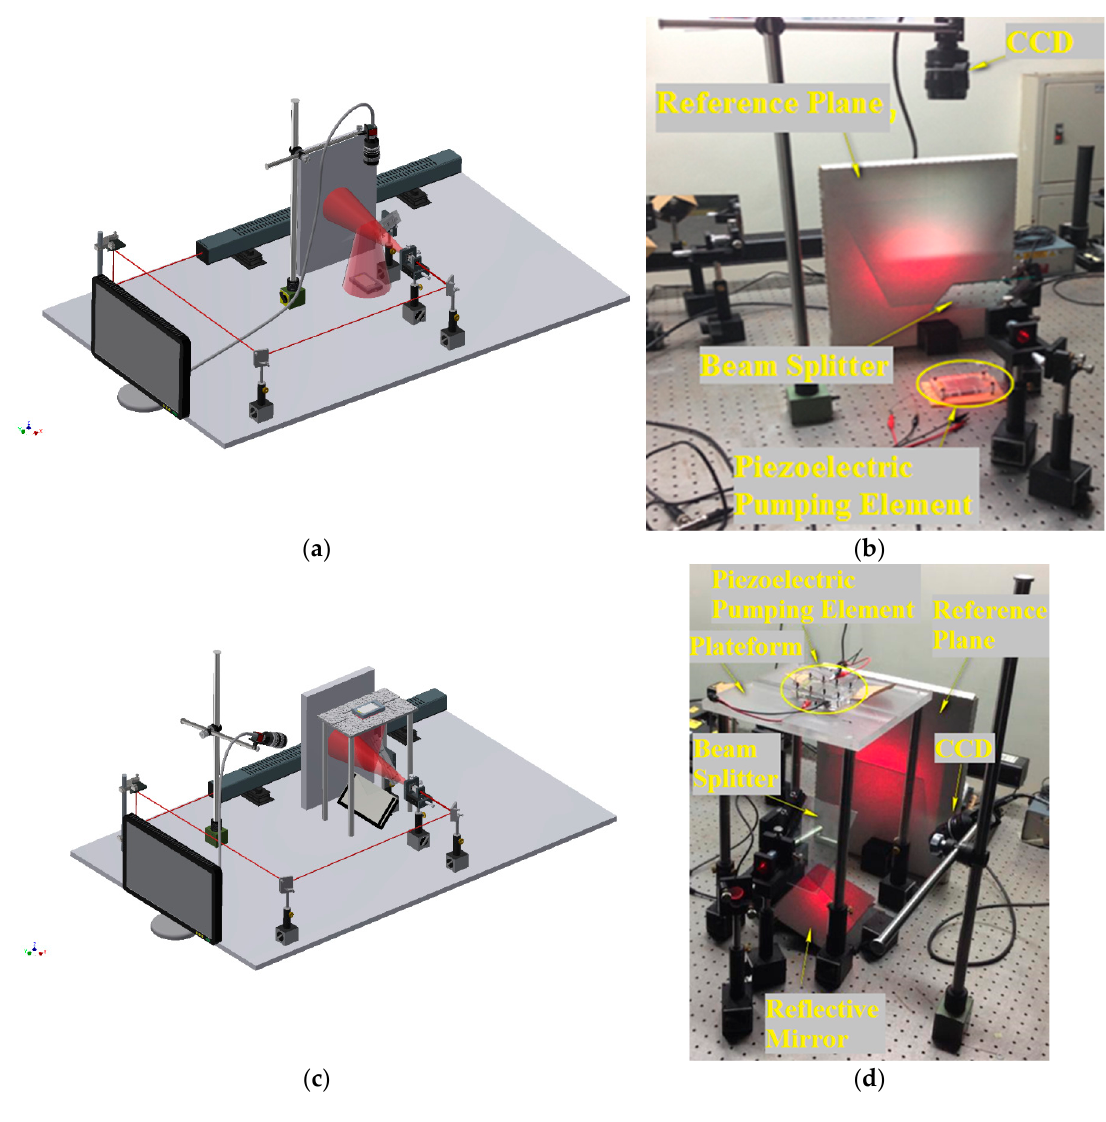
Figure 4. Schematic diagrams and implementations showing set-up of the amplitude-fluctuation electronic speckle pattern interferometry (AF-ESPI) experiment for out-of-plane measurements of upper and lower bimorphs: ( a ) the schematic diagram for the upper bimorph, ( b ) the implementation for the upper bimorph, ( c ) the schematic diagram for the lower bimorph, and ( d ) the implementation for the lower bimorph.